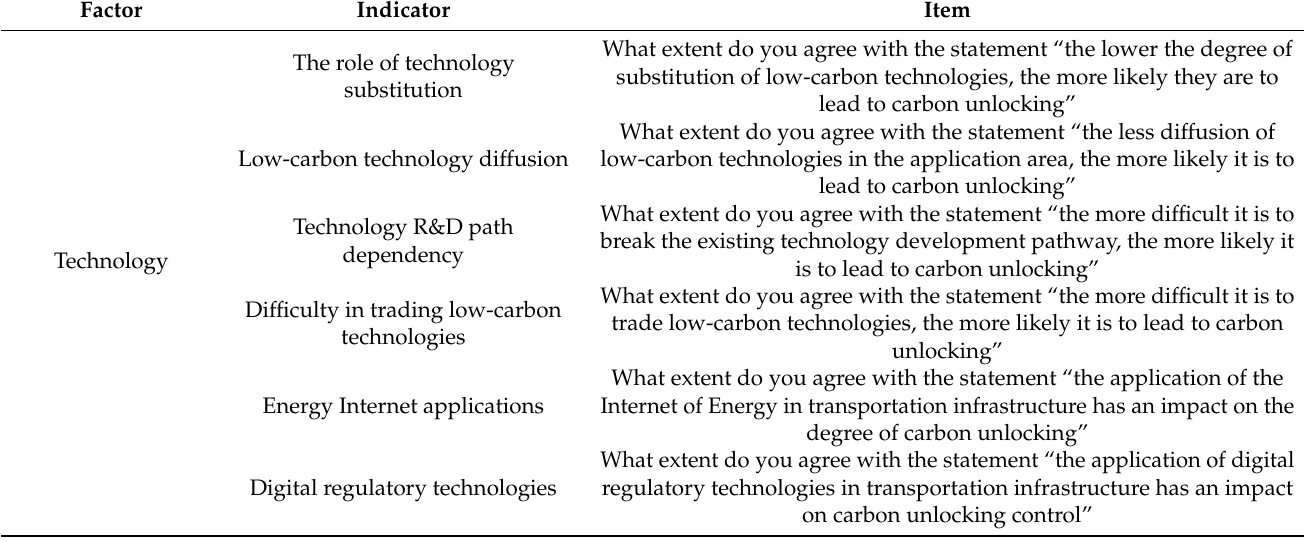
Table 3. Factors and indicators influencing carbon unlocking in transport